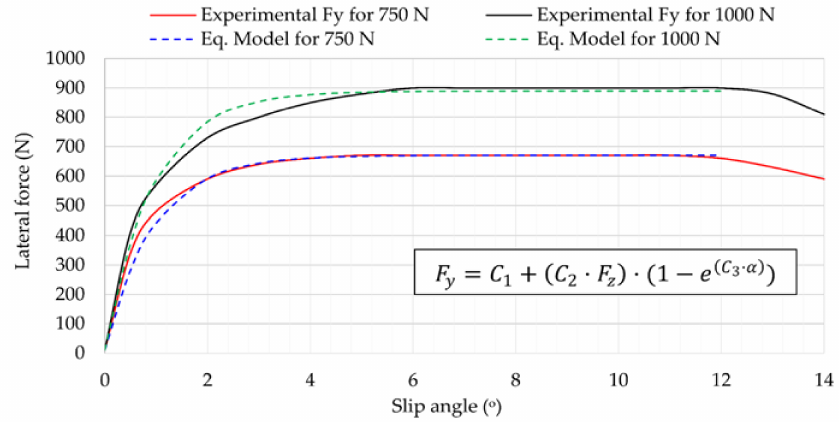
Figure 16. Experimental model adjusting to experimental F y data at 30 km/h, 0.8